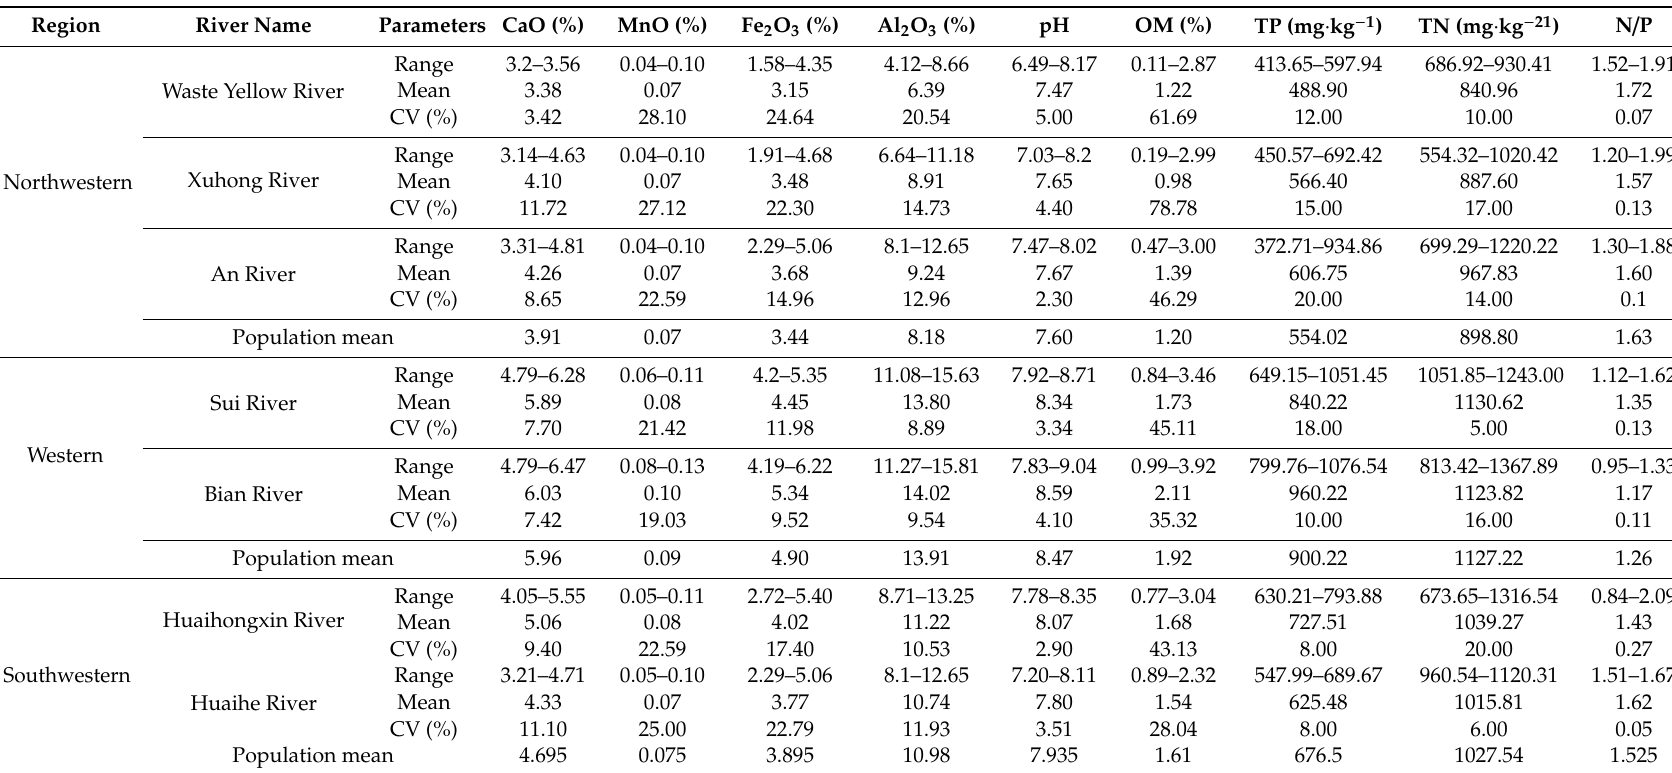
Table 1. Characteristics and physiochemical features of sediments. The organic matter (OM), total nitrogen (TN), total phosphorus (TP), inorganicphosphorus (Pi), organic phosphorus (Po), nitrogen / phosphorus (N / P). Coe ffi cient of Variation (C / V).